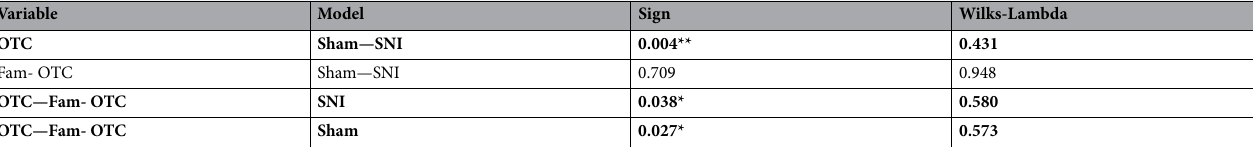
Table 3. Results of multivariate analysis of variance (MANOVA) in Fig. 3b, c. Significant values are in